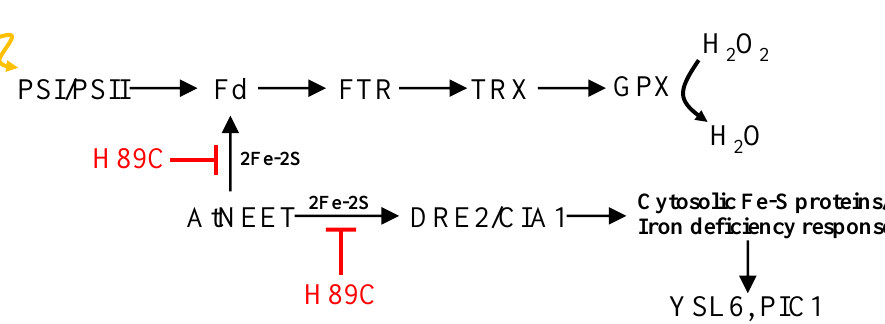
Figure 9. A simplified model for the dual role of AtNEET in plants. By providing 2Fe-2S clusters to ferredoxins, AtNEET is shown to support the function of the ferredoxin (Fd), Fd-thioredoxin (TRX) reductase (FTR), and TRX network of Arabidopsis (top). In addition, AtNEET is shown to play a key role in the mobilization of 2Fe-2S clusters from within the chloroplast to the cytosol and this function is shown to be important for regulating the level of different Fe-S cluster-containing proteins as well as the iron deficiency response of Arabidopsis. Functioning as a dominant-negative inhibitor of AtNEET iron cluster transfer functions, H89C is shown to block these two pathways. The model shown was developed based on the results obtained in the current study and the results presented in [9]. Abbreviations used: CIA1, Cytosolic Iron–Sulfur Protein Assembly 1; DRE2, Homolog of Yeast DRE2; Fd, ferredoxin; FTR, ferredoxin–thioredoxin reductase; GPX, glutathione peroxidase; PIC1, Permease in Chloroplasts 1; PSI, photosystem I; PSII, photosystem II; TRX, thioredoxin; YSL6, Yellow Stripe Like 6.